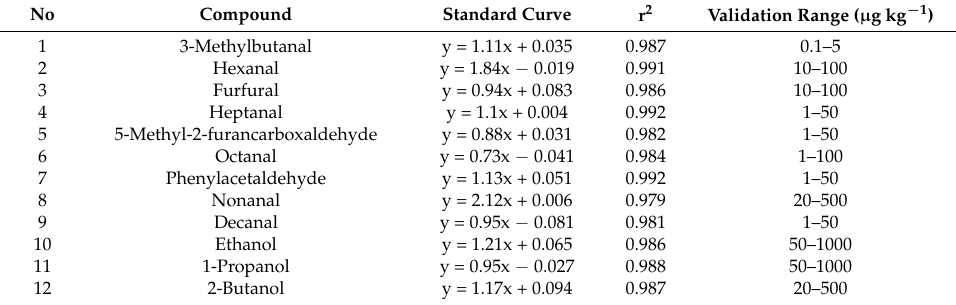
Table 2. The standard curve, validation range and coefficient of determination (r 2 ) for the volatile compounds in smoked bacon must. The equation based on the concentrations of peak areas and mean of six replicates at each of seven concentrations, total of 42 samples, “y” represents the peak area ratio and “x” indicates the concentration ratio. A model solution was used to test the quantities of the standards as described